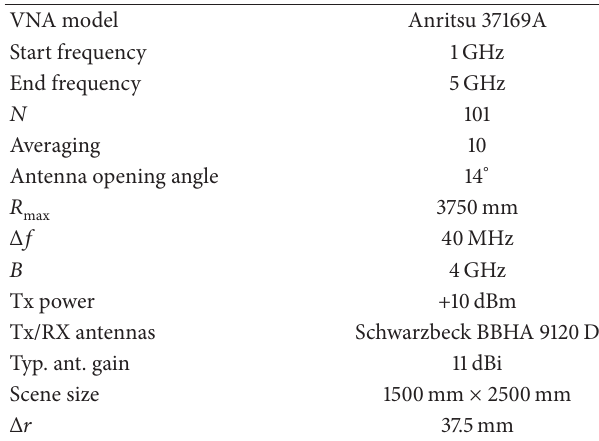
Table 1: Descriptive parameters of the TWI